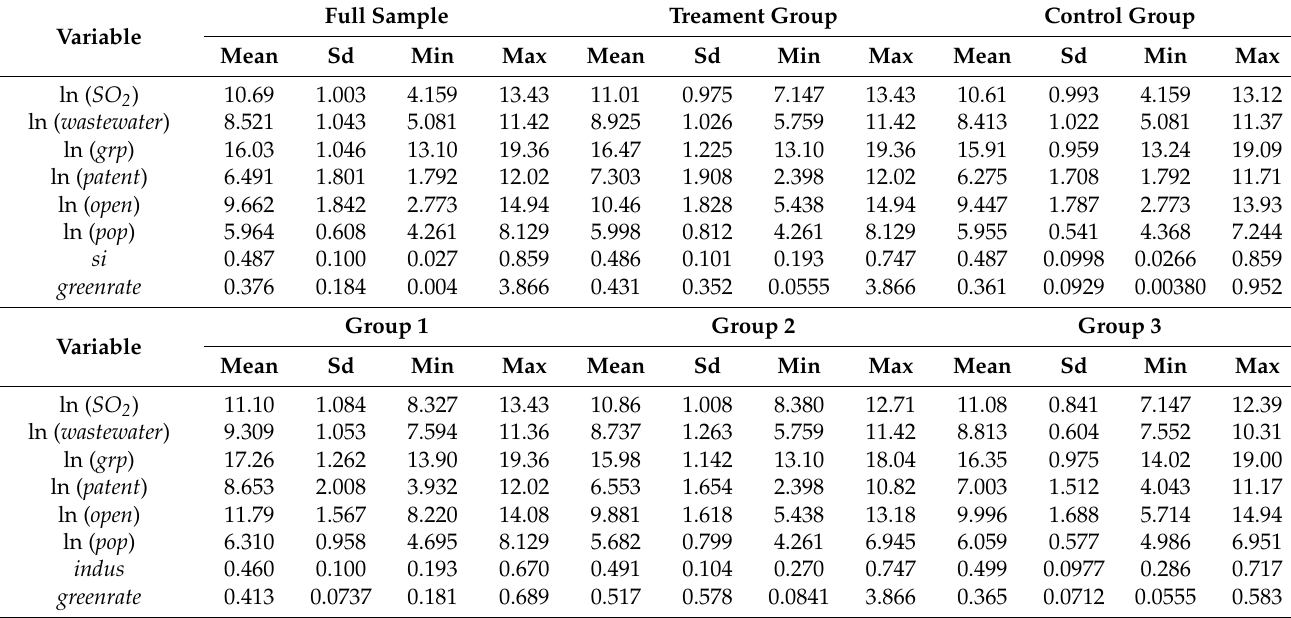
Table 3. Summary statistics of the key